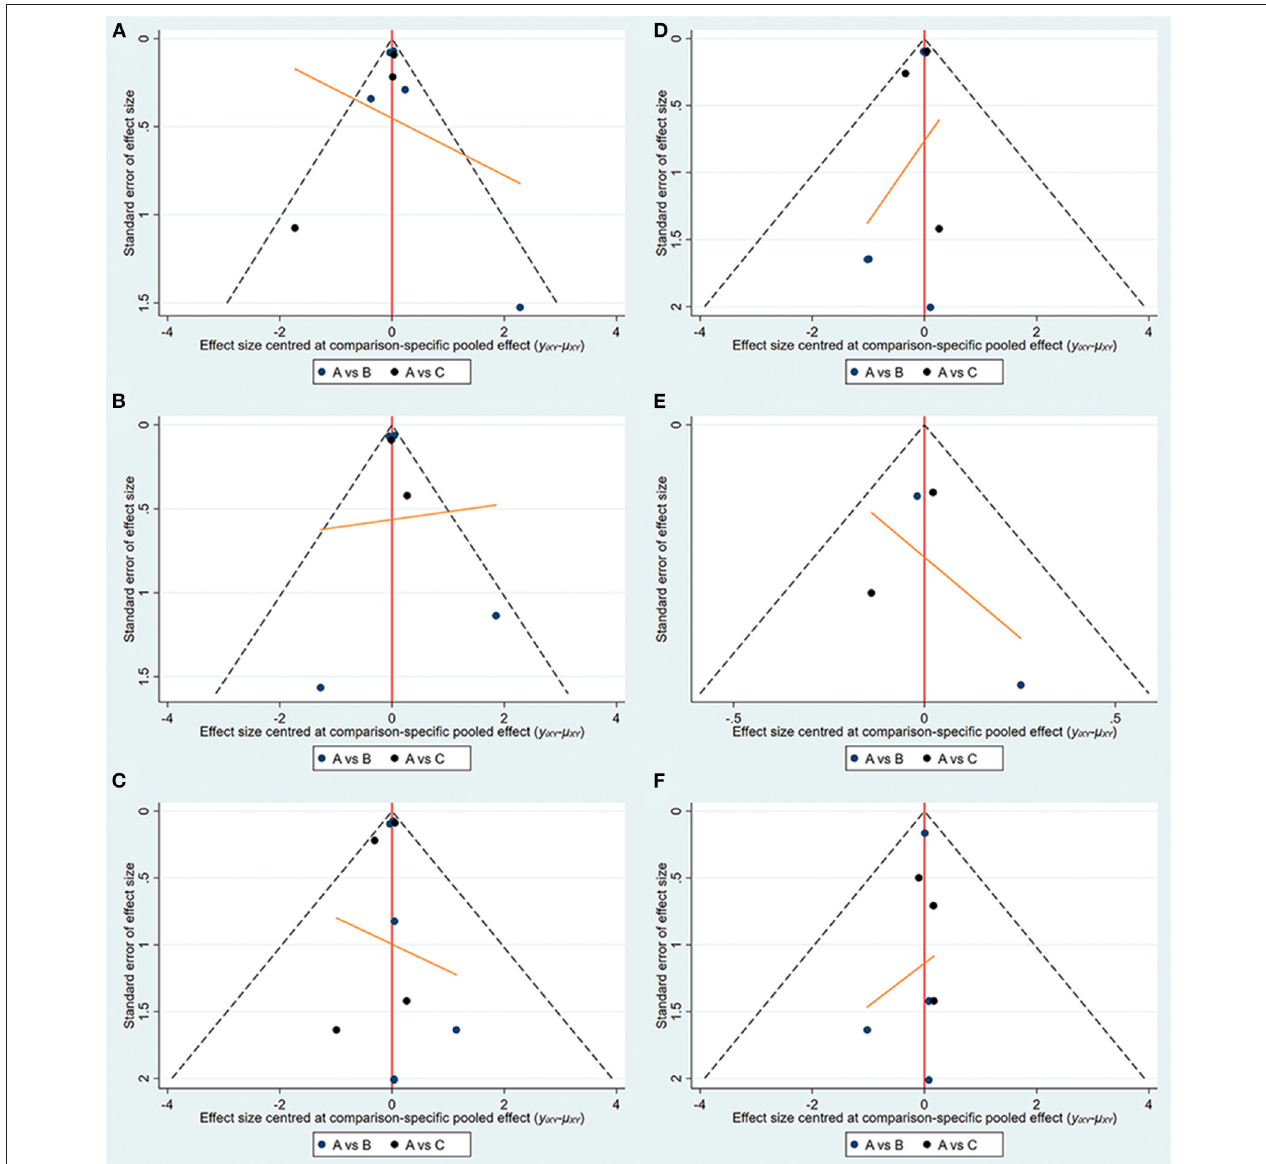
FIGURE 3 | Funnel plots (A:empagliflozin; B:dapagliflozin; C:placebo). (A) Hospitalization for HF; (B) exacerbation of HF; (C) all-cause death; (D) CV death; (E) CV death or hospitalization for HF; (F)